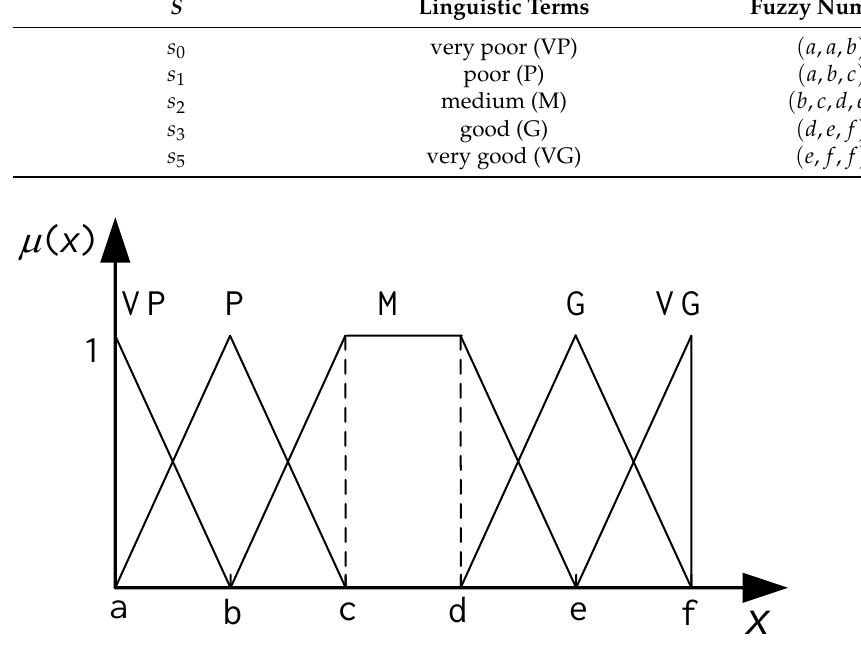
Figure 1. Linguistic terms and related fuzzy